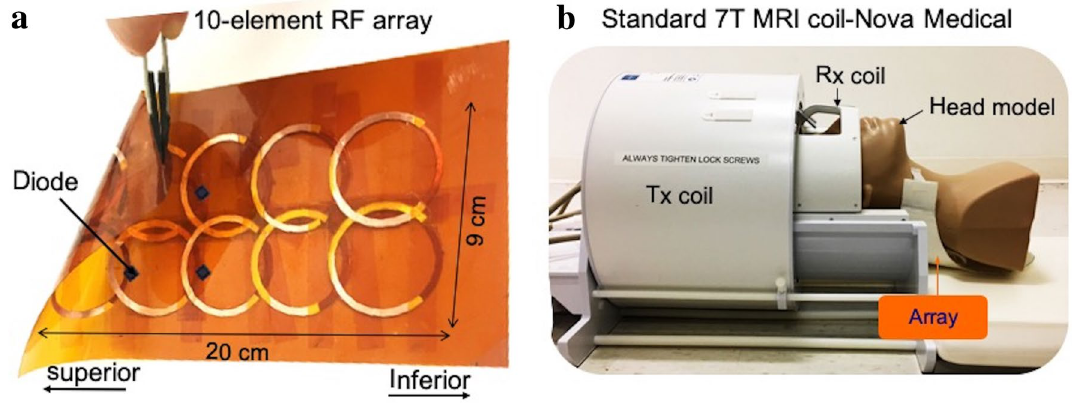
Figure 4. The prototyped RF array. ( a ) Prototype of the 10-element wireless passive RF resonator array constructed of 10 BCSRRs. Upon the substrate (Kapton), whose flexibility is shown by the instrument in the upper left, 10 SRRs were patterned on one side and 10 aligned but counter-oriented versions were applied to the other side. Critical overlapping distance (0.76D mm center-to-center) was used to reduce the inductive coupling between elements. Strongly coupled elements mainly in superior position were detuned using antiparallel cross diodes. (b) The picture of a standard head coil used in our MRI experiments and position of the array relative to the coil and a head